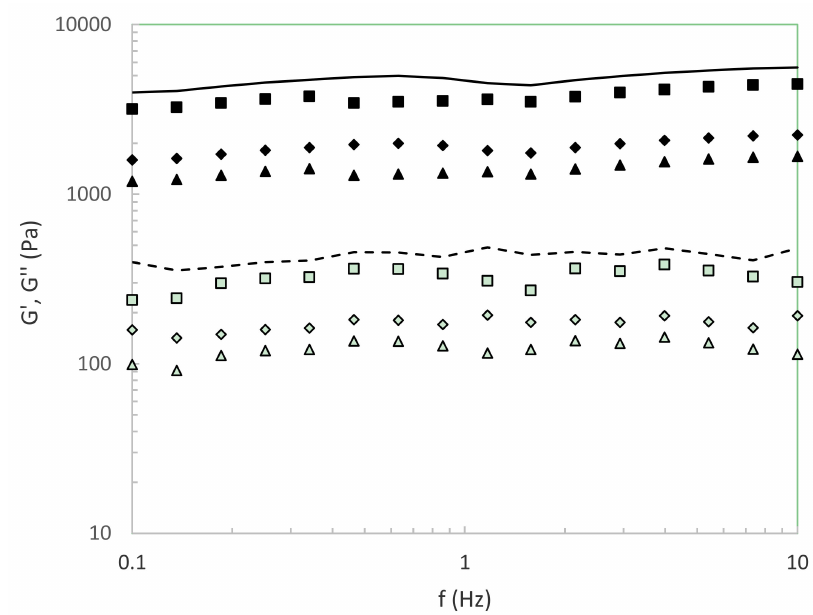
Figure 5. Viscoelastic features of functional starch-based hydrogels (10% w / w ) made with liquors at representative autohydrolysis temperatures ( ◦ C): 50 ( (cid:4) ), 210 ( (cid:78) ), and 250 ( (cid:7) ). Symbols: Elastic modulus (G (cid:48) ) (closed) and viscous modulus (G”) (open), lines represent the viscoelastic properties of